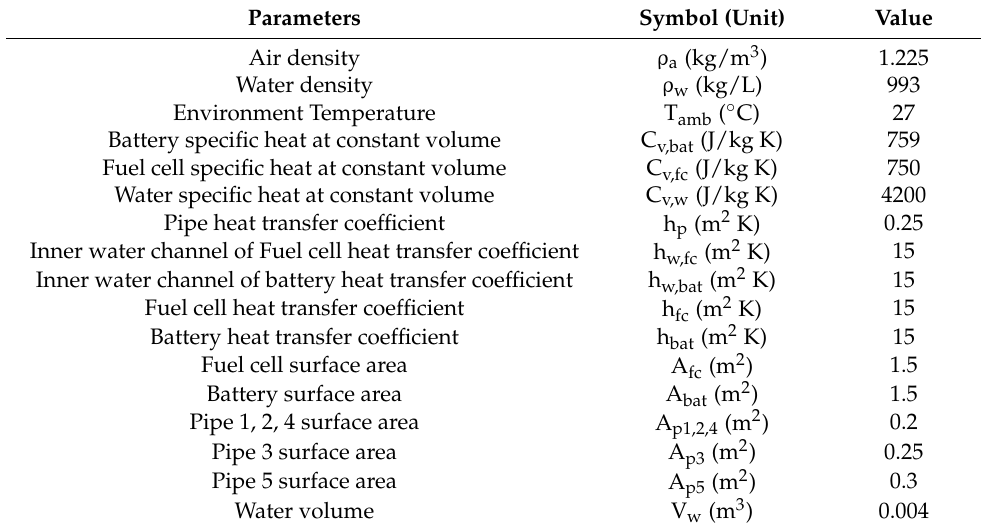
Table 2. Parameter values of the IHTMS simulator.